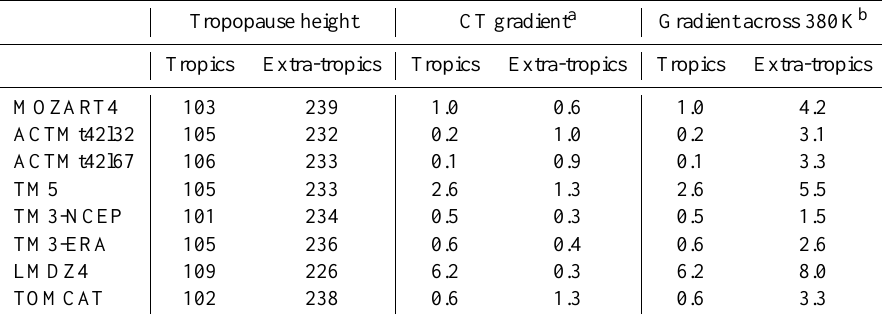
Table 6. Annual mean height of the tropopause (hPa) and the N 2 O gradient (ppb) across the tropopause (cross-tropopause CT) and the 380K isentrope. Tropics are defined as between 10 ◦ S and 10 ◦ N and extra-tropics are defined as latitudes higher than 30 ◦ .